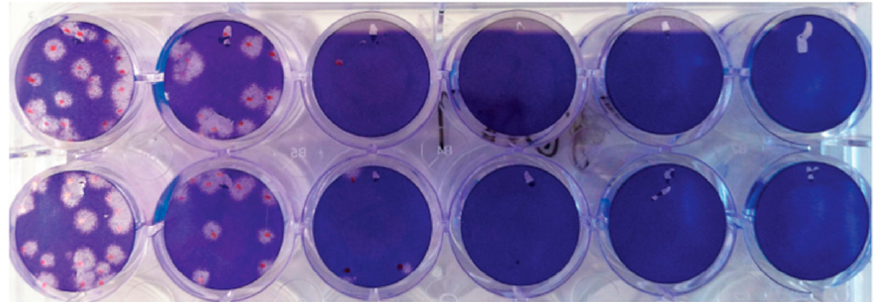
Figure 1. Example of plaque reduction neutralization performed in duplicate. Overlay fixed with 4% paraformaldehyde and stained with crystal violet before plaques were counted.